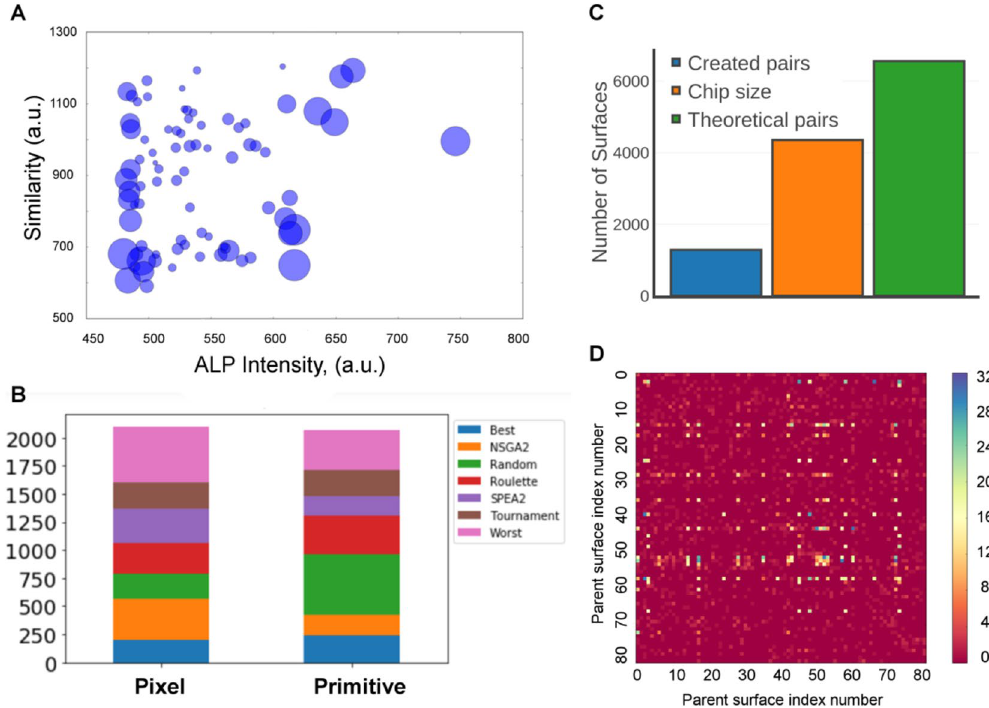
Figure 4. Exploration of Genetically modified TopoChip. ( A ) Bubble chart in which the bubble size represents the number of progeny for every parent. Y-axis represents similarity measured with Pearson correlation. The x-axis represents ALP intensity in the initial screen. ( B ) The frequency of the selection algorithm for both Pixel- based and primitive based gene representations. ( C ). Quantification of factual, possible and theoretical parents’ pairs. ( D ) Quantification of pairs formed by the parent surfaces in